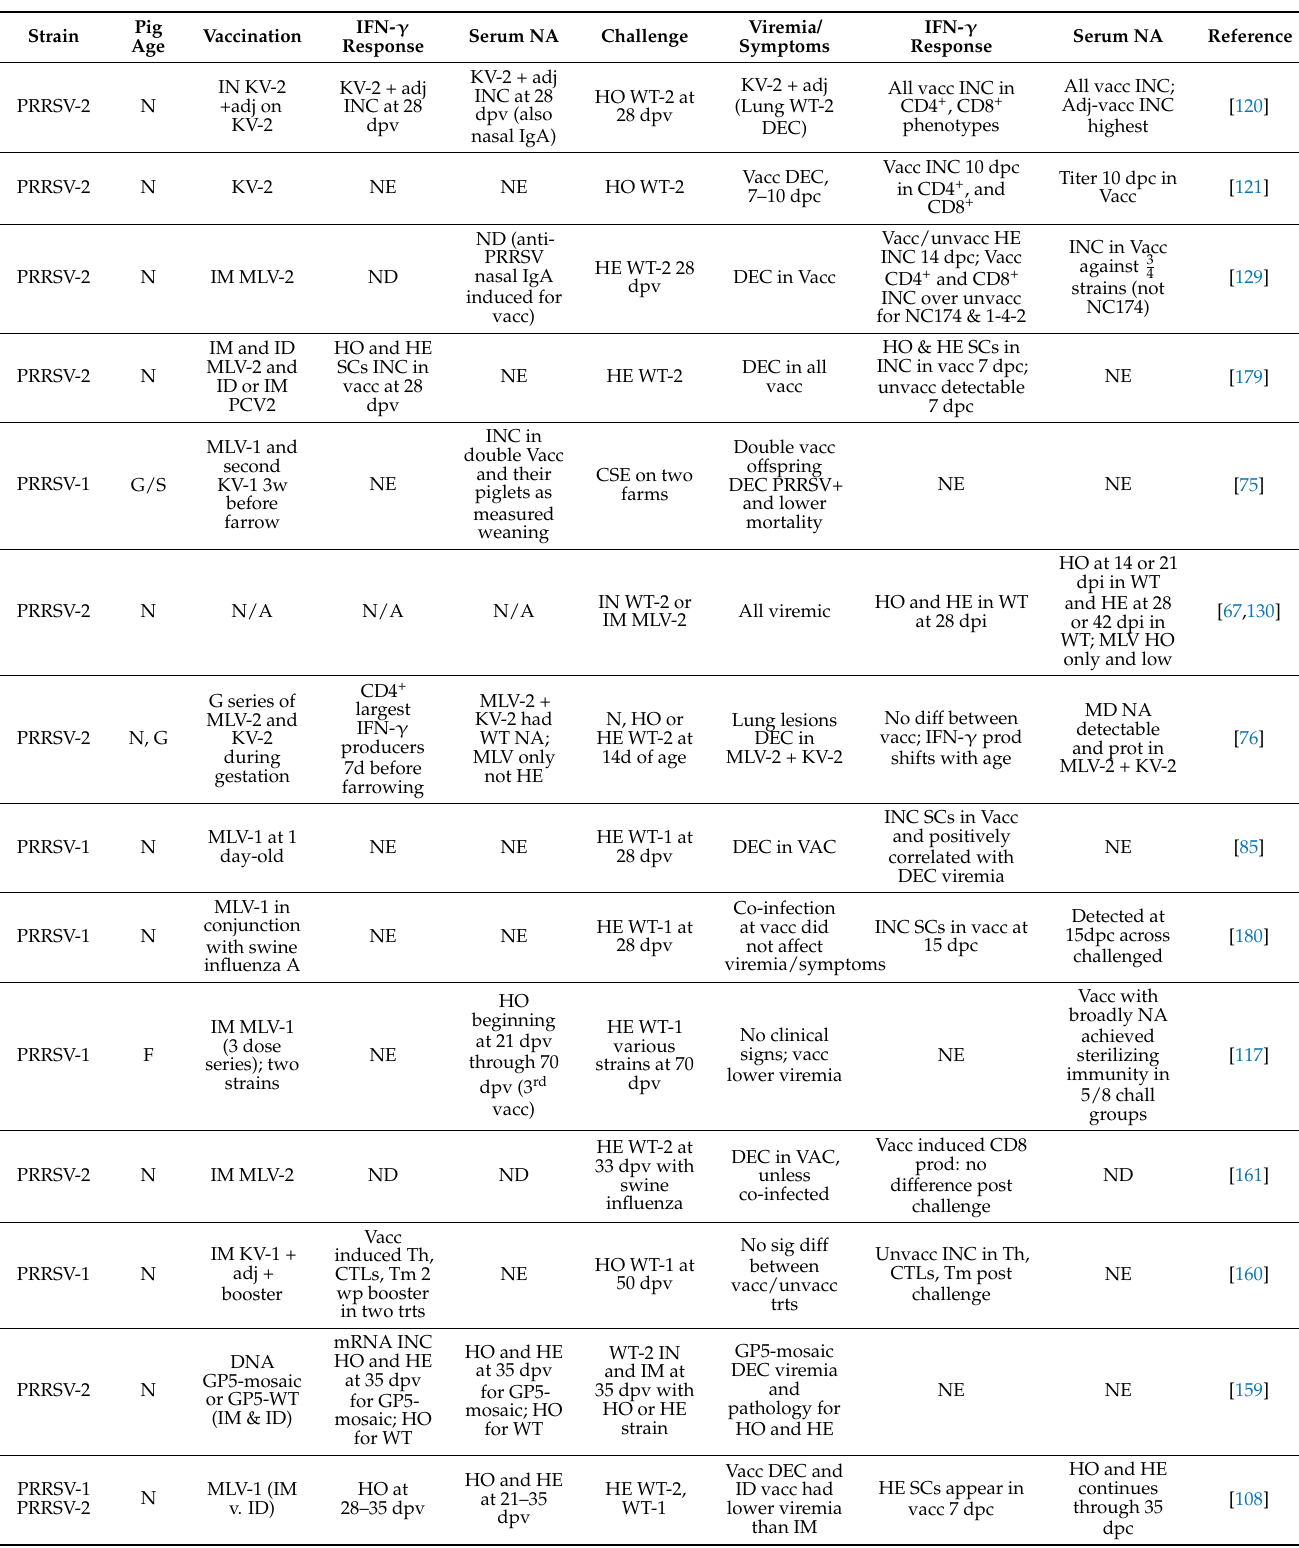
Table 1. Comparison of pig age, IFN- γ secreting cells, and serum NA in PRRSV vaccination or